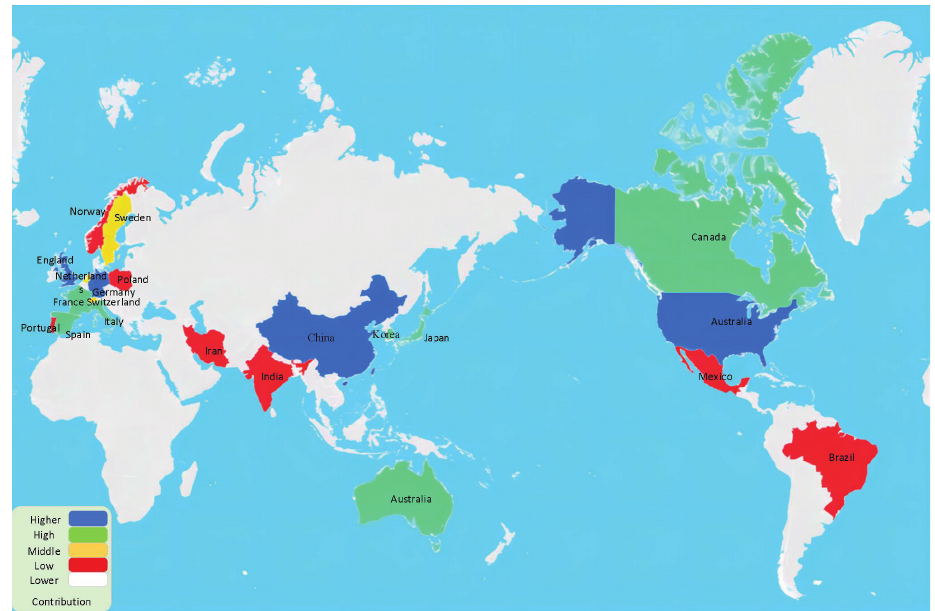
Figure 11. Contributions of different countries to